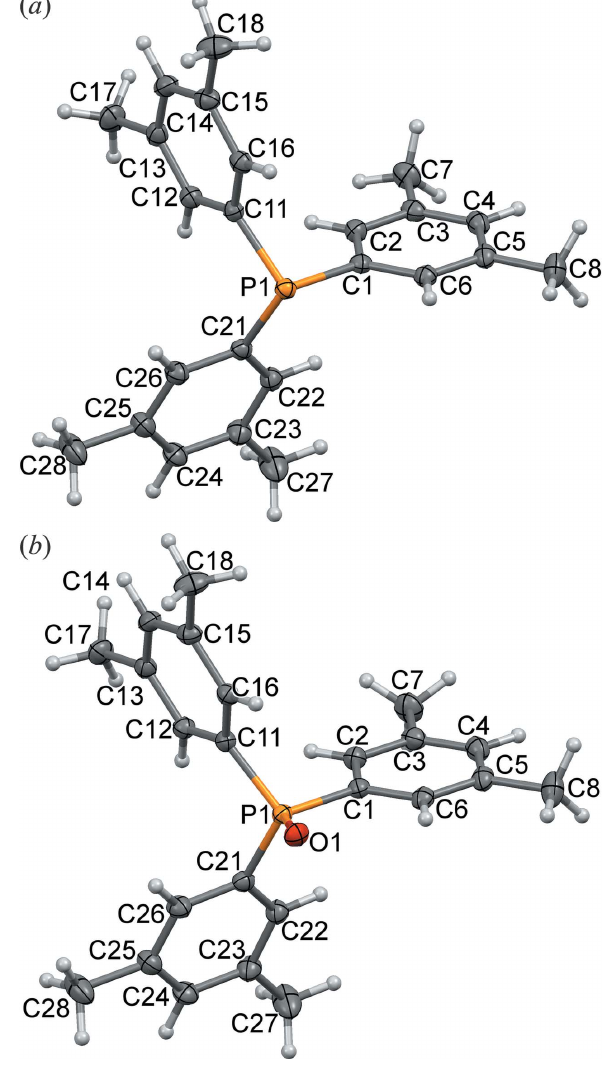
Figure 1 Displacement ellipsoid plots (50%) of ( a ) phosphine (I) and ( b ) phosphine oxide (II), including the atom-numbering